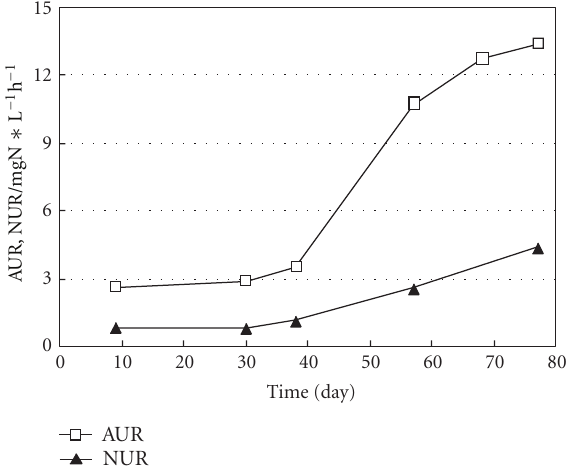
Figure 3: The ammonia uptake rate and nitrite uptake rate of the activated sludge in main-stream